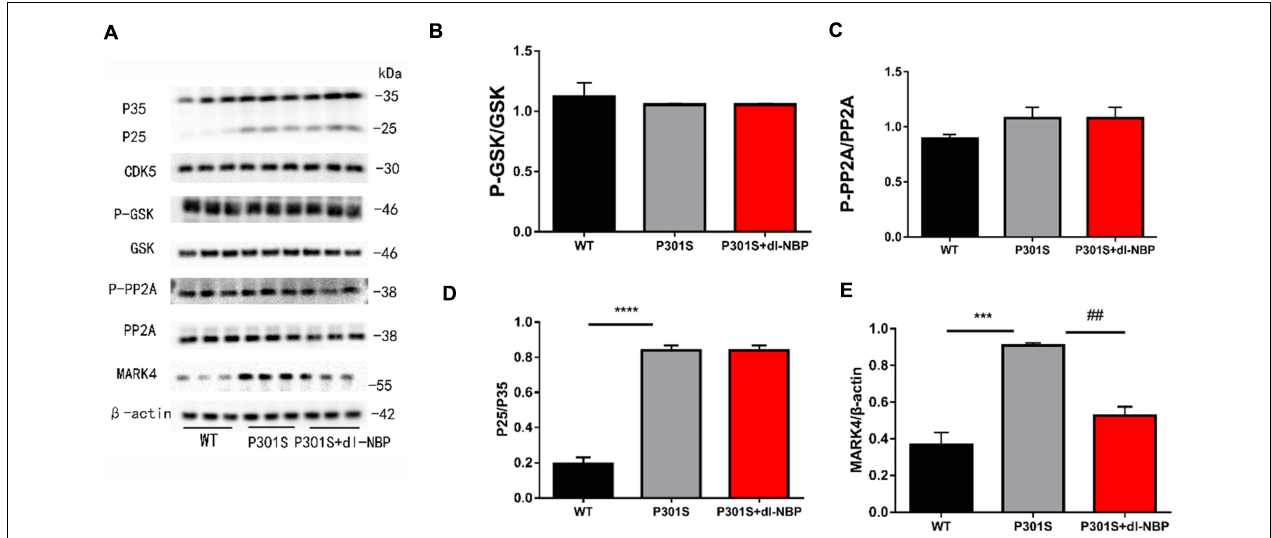
FIGURE 4 | dl-NBP ameliorates tau phosphorylation via MARK4 in P301S mice. (A) Western blotting of P25-35, CDK5, PP2A, GSK-3 β , P-GSK-3 β , and MARK4. β -Actin served as the loading control. (B) Quantitative analysis of P25/P35 ratio. (C) Quantitative analysis of PP2A/P-PP2A ratio. (D) Quantitative analysis of GSK-3 β /P-GSK-3 β ratio. (E) Quantitative analysis of MARK4/ β -actin. All results were presented as mean ± SEM ( n = 4). *** P < 0.001, **** P < 0.0001, WT mice vs. P301S mice; ## P < 0.01, P301S mice vs. P301S + dl-NBP